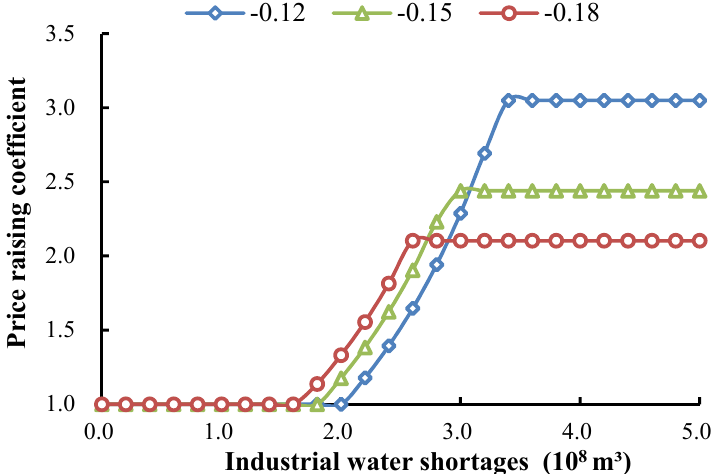
Figure 10. The impact of price elasticity of residential water on PSRW. When the price elasticity coefficient is − 0.12, the industrial water shortage levels corre- sponding to the starting and stopping points of price raising are 2.0 × 10 8 and 3.4 × 10 8 m 3 , respectively, the difference between upper bound and lower bound is 1.4 × 10 8 m 3 , and the maximum price raising coefficient is 3.05. When price elasticity coefficient is − 0.15, the industrial water shortage levels corresponding to the starting and stopping points of price raising are 1.8 × 10 8 and 3.0 × 10 8 m 3 , respectively, the difference between upper bound and lower bound is 1.2 × 10 8 m 3 , and the maximum price raising coefficient is 2.44. When price elasticity coefficient is − 0.18, the industrial water shortage levels corresponding to the starting and stopping points of price raising are 1.6 × 10 8 and 2.6 × 10 8 m 3 , respectively, the difference between upper bound and lower bound is 1.0 × 10 8 m 3 , and the maximum price raising coefficient is 2.10. It shows that the larger the absolute value of price elasticity